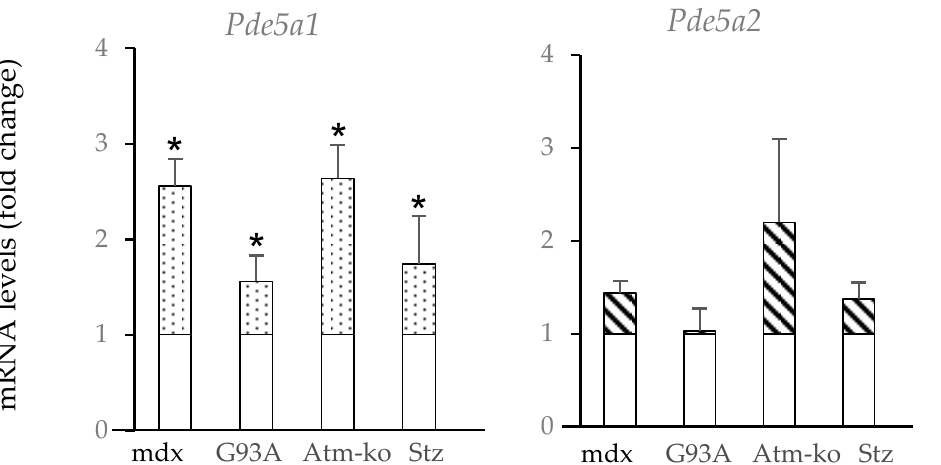
Figure 2. mRNA Pde5a isoform expression in skeletal muscle under pathological conditions. mRNA levels of Pde5a isoforms were measured by RT-qPCR. mRNA levels in the pathological samples are expressed as the fold change compared with the samples from muscles collected from wild-type mice (empty columns). Relative expression levels of Pde5a1 (dotted columns) and Pde5a2 (striped columns) isoform are depicted. All values represent the mean ± SD of at least n = 4 different RNA preparations. * Indicates statistical significance of pathological samples compared with control samples ( t -test: p < 0.05).